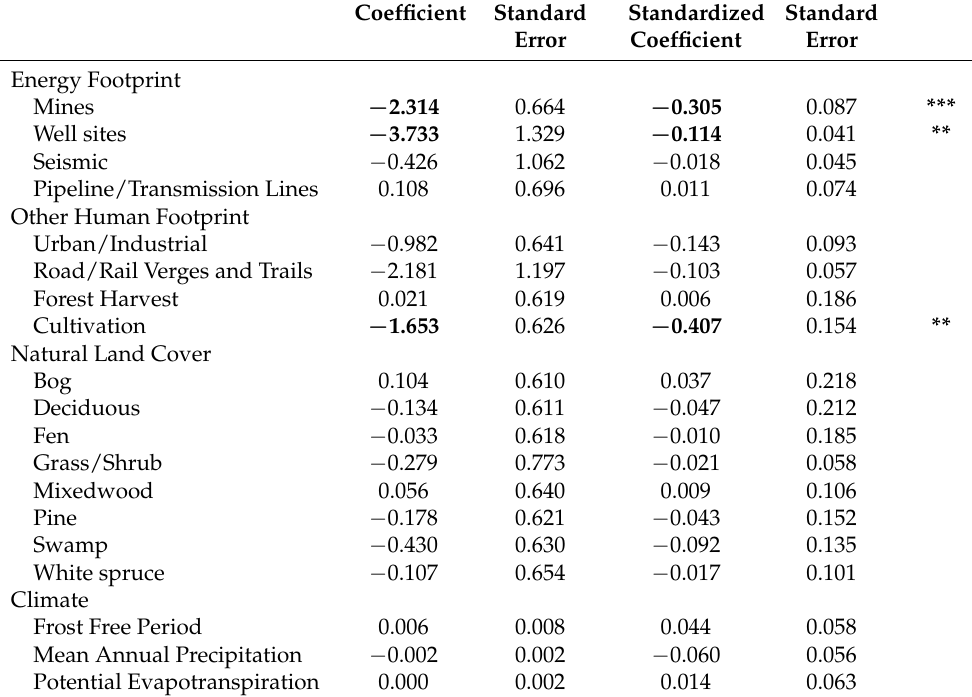
Table A2. Summaries of multiple regression model of total abundance of oribatid mites in the oil sands region of Alberta,